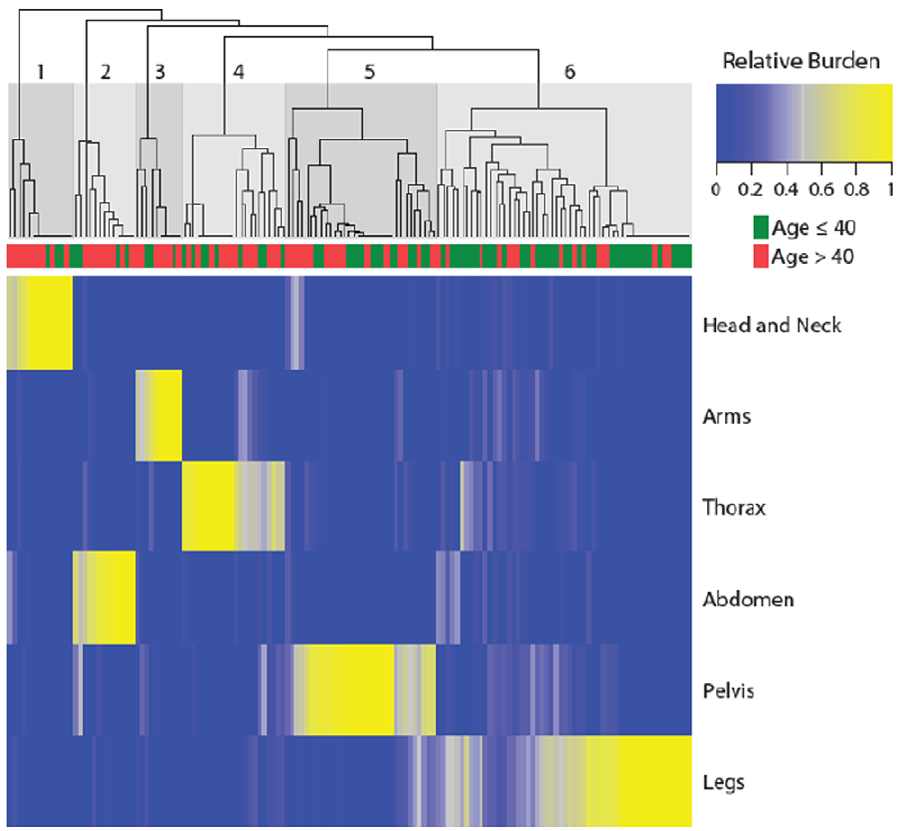
Figure 4. Results of unsupervised hierarchical clustering of patients based on relative tumor volume across body regions. (This figure is an interactive display. It is currently available for at www.wholebodymri.org). Unsupervised hierarchical clustering of relative tumor volume across body region (head/neck, trunk, extremities) for 145 subjects with internal nerve sheath tumors. Total tumor volumes were combined and scaled for each patient. Regions with higher tumor burden are shown in yellow. Individual patients are represented as columns and the maximum intensity projection (MIP) of the whole-body MRI scan is shown to the right of the clustering figure. For each patient, the Gini coefficient is shown in the lower left and the whole-body tumor volume in the lower middle. doi:10.1371/journal.pone.0035711.g004 PLoS ONE |